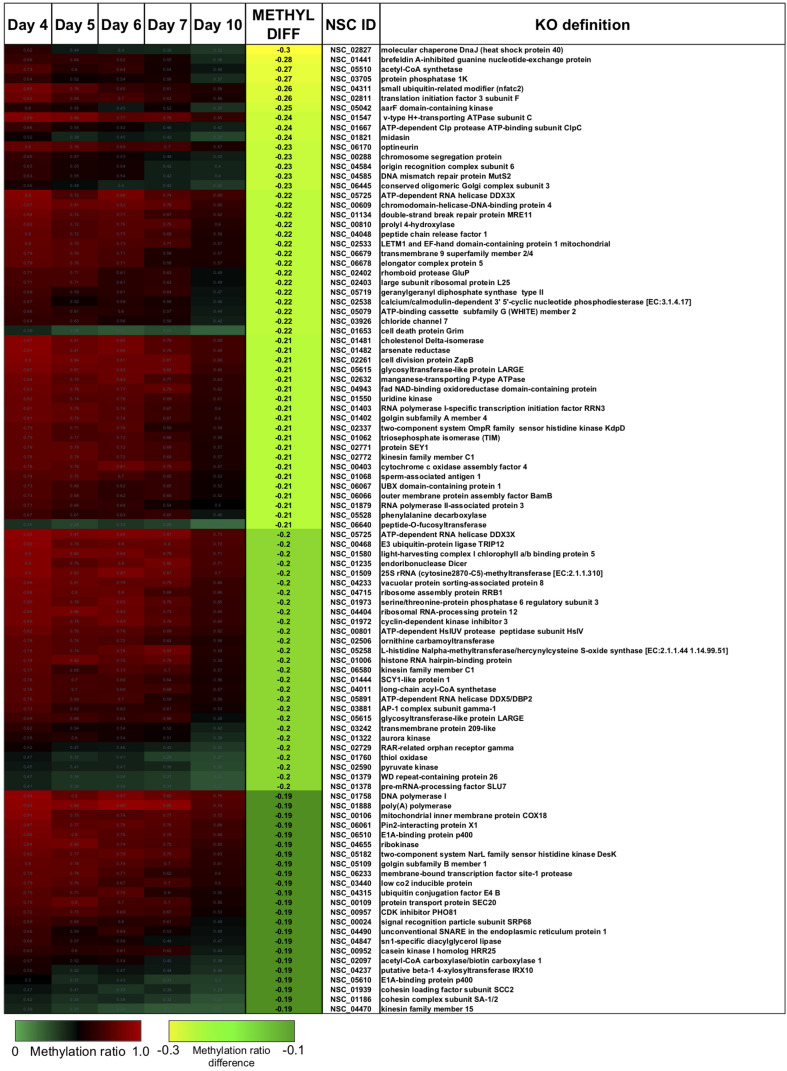
The top 100 CpG sites that became significantly hypomethylated across the growth cycle of P. soloecismus. The top 100 annotated sites with the greatest change in methylation ratio across the growth cycle from Day 4 to Day 10 are listed (p < 0.01 for all sites). The greatest change in methylation ratio (–0.3) is shown under the column METHYL DIFF in yellow; change in methylation ratio decreases in absolute value down the column (dark green). Sites are largely methylated (red) and become less methylated (darker, black). Few sites have lower methylation (lighter green) and become less methylated over time (darker green). Some sites start with moderate methylation (black) and become hypomethylated (green). Annotations (NSC_ID corresponding to the P. soloecismus genomic ID) and the KO (KEGG Orthologies, within E-24) definitions are provided.